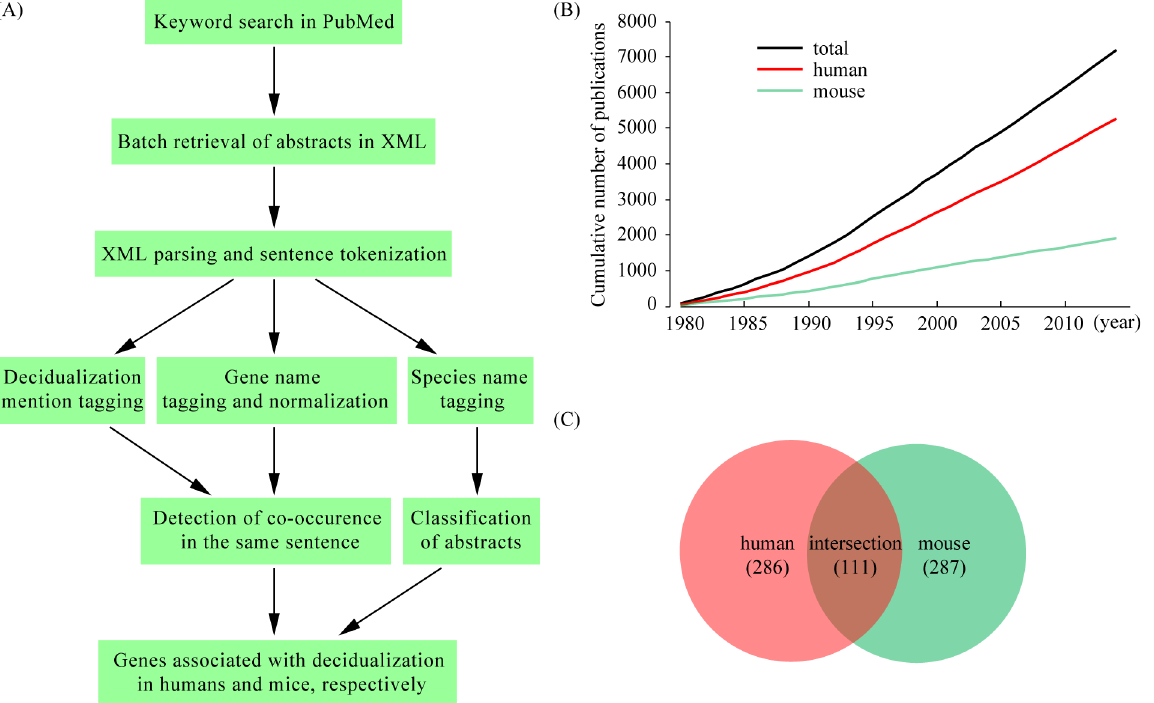
Fig 1. Systematic identification of genes associated with decidualization in humans and mice through text mining. (A) Overview of the text mining process. (B) The cumulative number of publications on decidualization. The PubMed database was used to identify publications related to decidualization from 1980-Jan to 2014-Aug. (C) Venn diagram comparing the gene sets associated with decidualization in humans and mice, respectively.